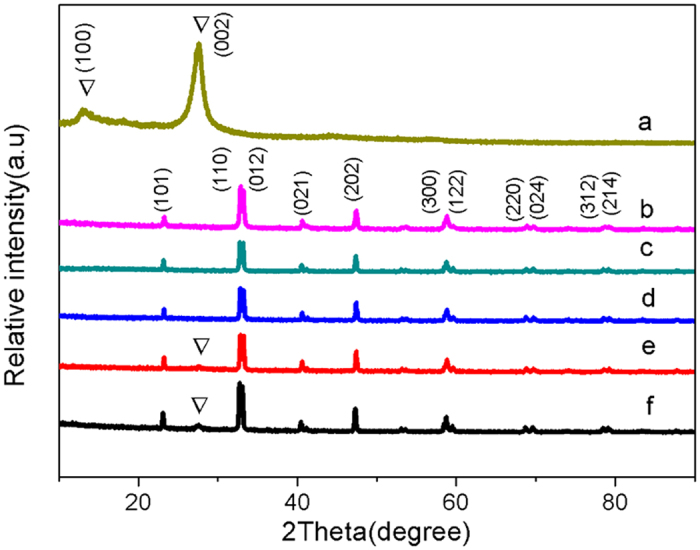
XRD patterns of (a) g-C3N4, (b) LaNiO3, (c) 5 wt.% CNL, (d) 10 wt.% CNL, (e) 20 wt.% CNL, (f) 30 wt.% CNL hybrid catalyst. The weight percentage number imply the g-C3N4.